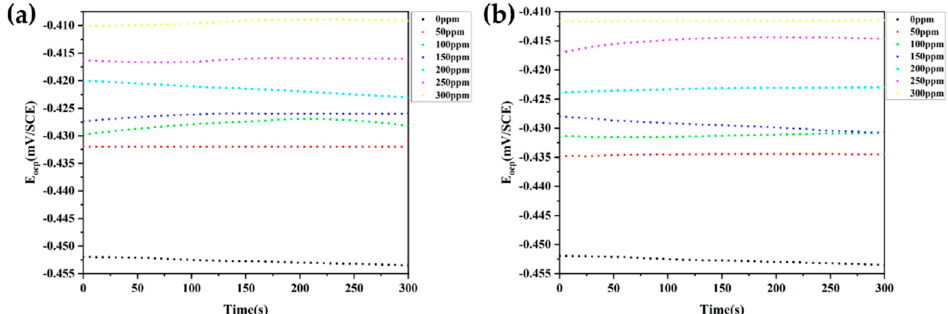
Figure 3. The variation of OCP with time for N80 steel in 1 M HCl solution containing different concentrations of ( a ) MPO, ( b ) MPPO at 305 K.